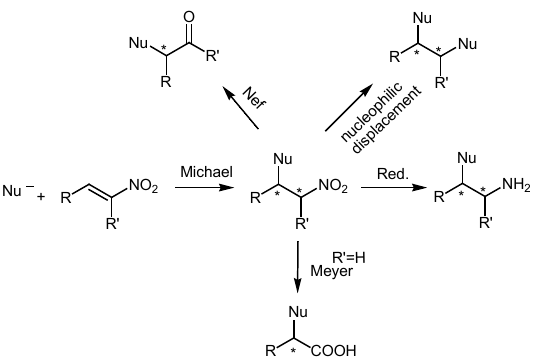
Figure 1. Possible trasformations of nitro group.